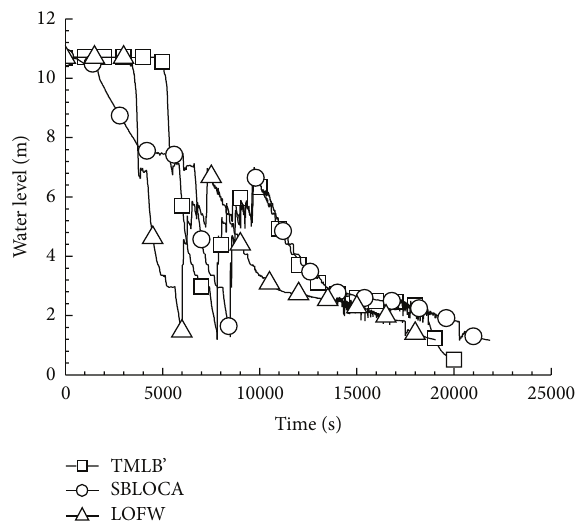
Figure 9: Water level of RPV with activation of SADV.